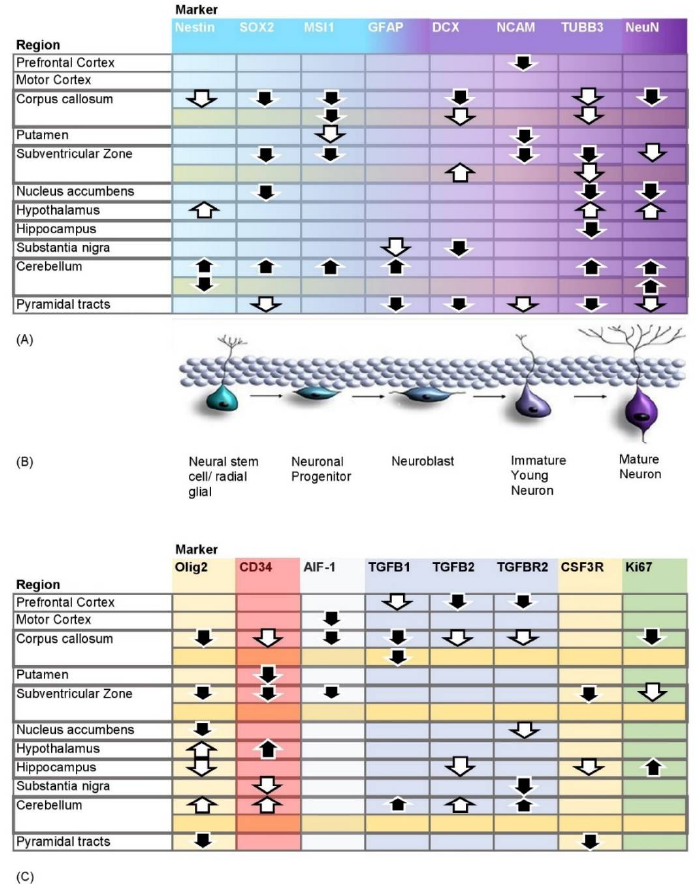
Figure 2. Overview of regions and markers studied. ( A , C ) provide an overview of all studied regions and markers. Downward pointing black arrows with white border show significant downregulation ( p = ≤ 0.05) in the corresponding brain region, upward pointing black arrows with white border show significant upregulation ( p = ≤ 0.05). Downward pointing white arrows with black border show a trend towards downregulation ( p = ≤ 0.1), upward pointing black arrows with white border show a trend towards upregulation ( p = ≤ 0.1). ( A ) shows the markers of neuronal differentiation in chronological order from neural stem cells to mature neurons. Neuronal differentiation is illustrated in ( B ). ( C ) shows the non-neuronal markers. Rows show results of mRNA, except for the second rows of each corpus callosum, subventricular zone and cerebellum, highlighted in yellow, showing the protein